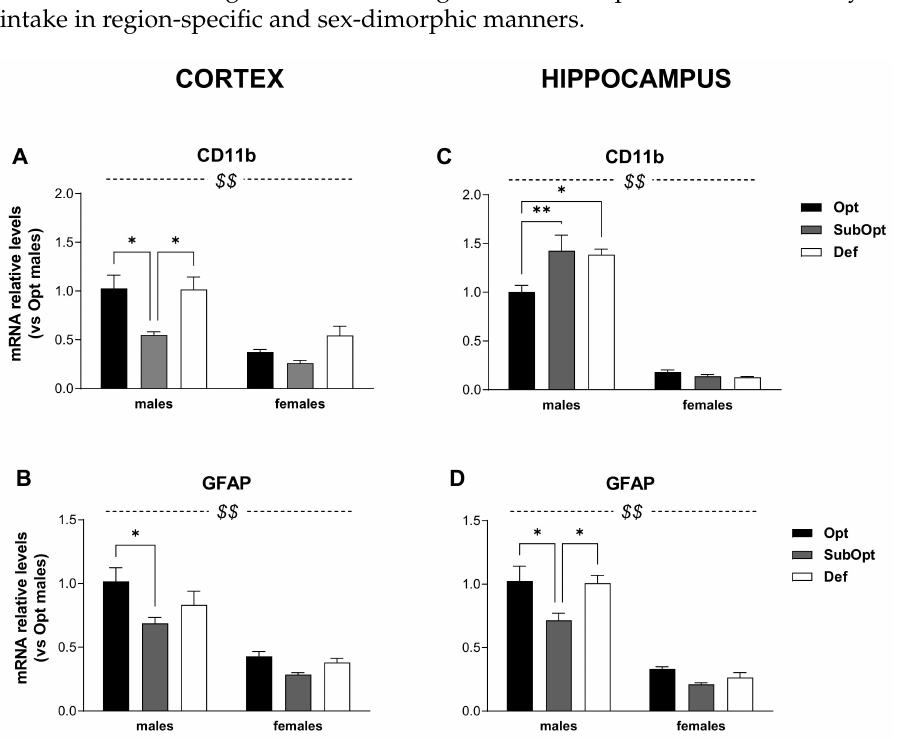
Figure 3. Effects of different Se supply on the level of CD11b and GFAP mRNA in the offspring’s cortex and hippocampus, evaluated by real-time PCR. The relative expression level of each mRNA was calculated using the 2 − ∆∆ Ct method, normalized to β -actin, and relative to the control group (i.e., male rats of the Opt Se dietary group). Each bar represents the mean ± SEM ( n = 5M, 5F). Cortex ( A , B ) $$ p < 0.0001 females vs. males (CD11b: p = 0.001 for Se Opt females vs. males; p = 0.015 for Se Def females vs. males. GFAP: p < 0.0001 for Se Opt females vs. males; p = 0.005 for Se SubOpt females vs. males; p = 0.001 for Se Def females vs. males; Tukey’s post hoc test); * p < 0.05. Hippocampus ( C , D ) $$ p < 0.0001 females vs. males ( p < 0.001 for female vs. male rats within all dietary groups, for both genes; Tukey’s post hoc test); * p < 0.05, ** p < 0.01. CD11b, cluster of differentiation 11b; GFAP, glial fibrillary acidic protein; PCR, Polymerase Chain